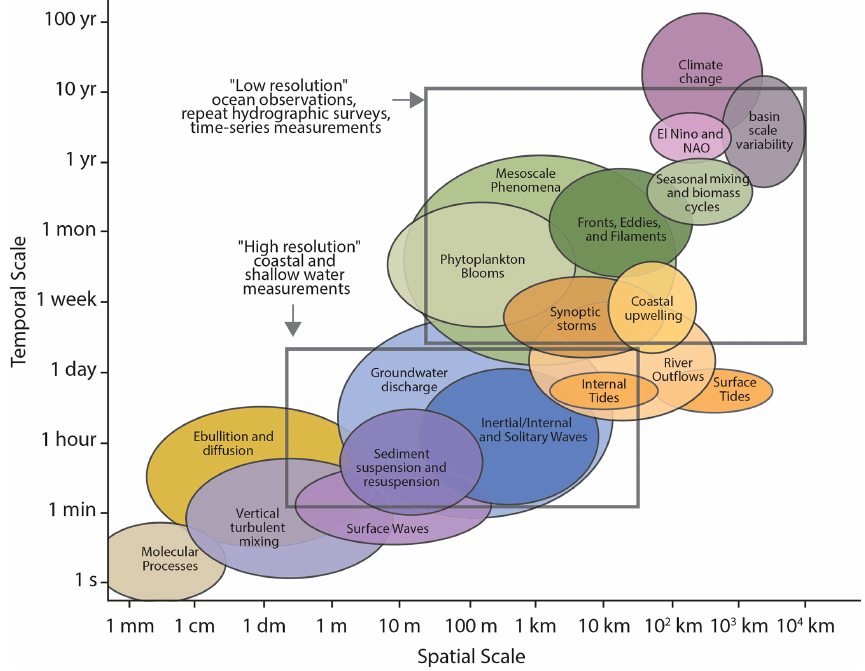
Figure 3. Time–space scale diagram illustrating various physical, biological, and climatological processes relevant to marine CH 4 and N 2 O (adapted from Dickey, 2003). To date, the majority of marine CH 4 and N 2 O measurements resolve variability at the mesoscale level or higher. Recent technological developments and the need to resolve concentrations and fluxes in shallow water environments will increase the number of measurements conducted at the sub-mesoscale level (see Fig. 5). The low-resolution oceanographic surveys are more likely to achieve a high level of analytical accuracy compared to high-resolution coastal measurements; however this is compensated for by high temporal resolution achieved by underway